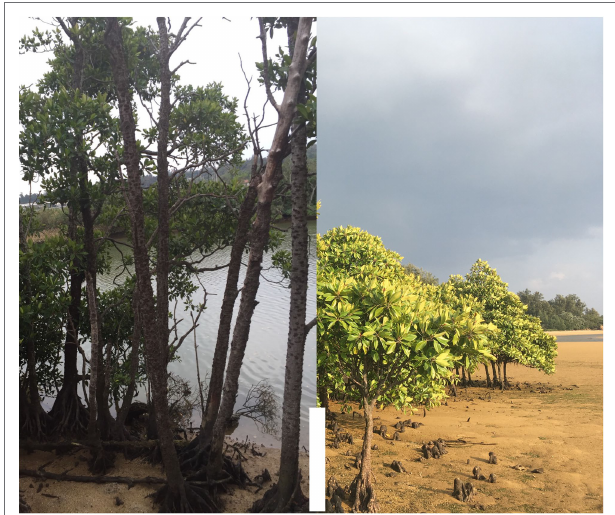
FIGURE 1 | Two populations of a mangrove tree ( Bruguiera gymnorhiza ) growing in their natural habitat only about 1 km apart from each other. One population (left) located along the estuary of the Okukubi River (Kin town, Okinawa Island, Japan: 26 ° 27 ′ N, 127 ° 56 ′ E), in fresh/brackish water, showing tall tree-like morphology, and the other population (right) grow, in the coastal area of Pacific Ocean in saline environment, showing shrub-like phenotype. The scale bar marks about 100 cm. This is a typical characteristic of mangrove community. They usually show gradient morphological changes according to their environment ranging from fresh to saline water which makes them a natural laboratory for studying climate change and epigenetic